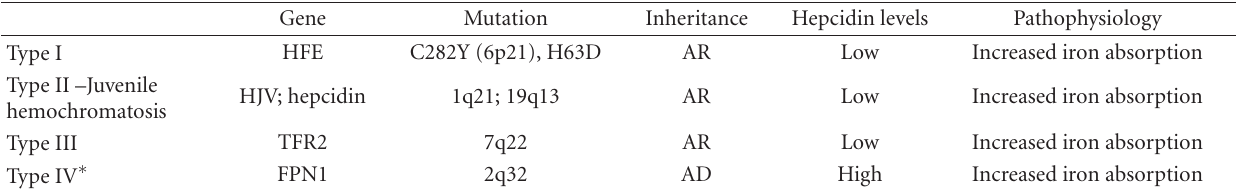
Table 1: Characteristics of Hereditary